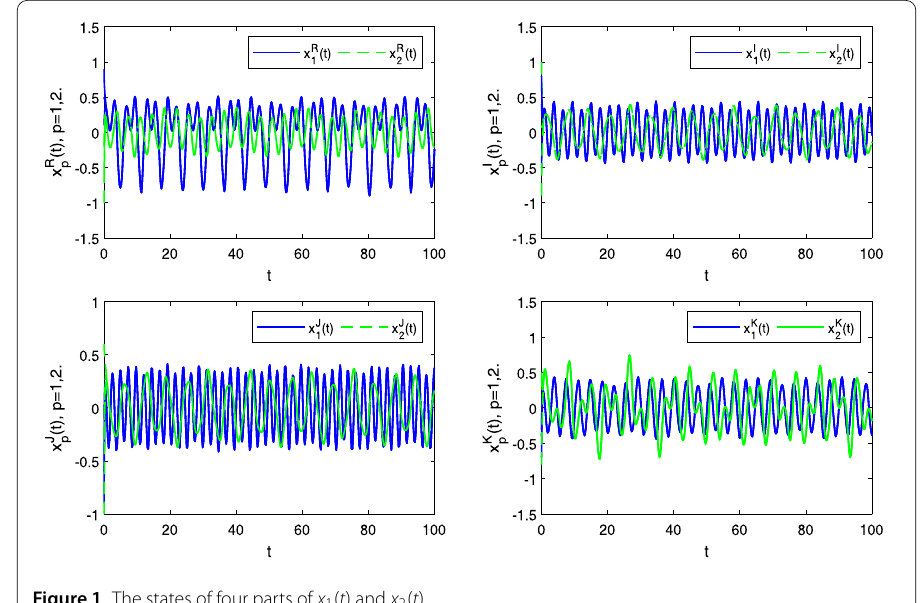
Figure 1 The states of four parts of x 1 ( t ) and x 2 ( t